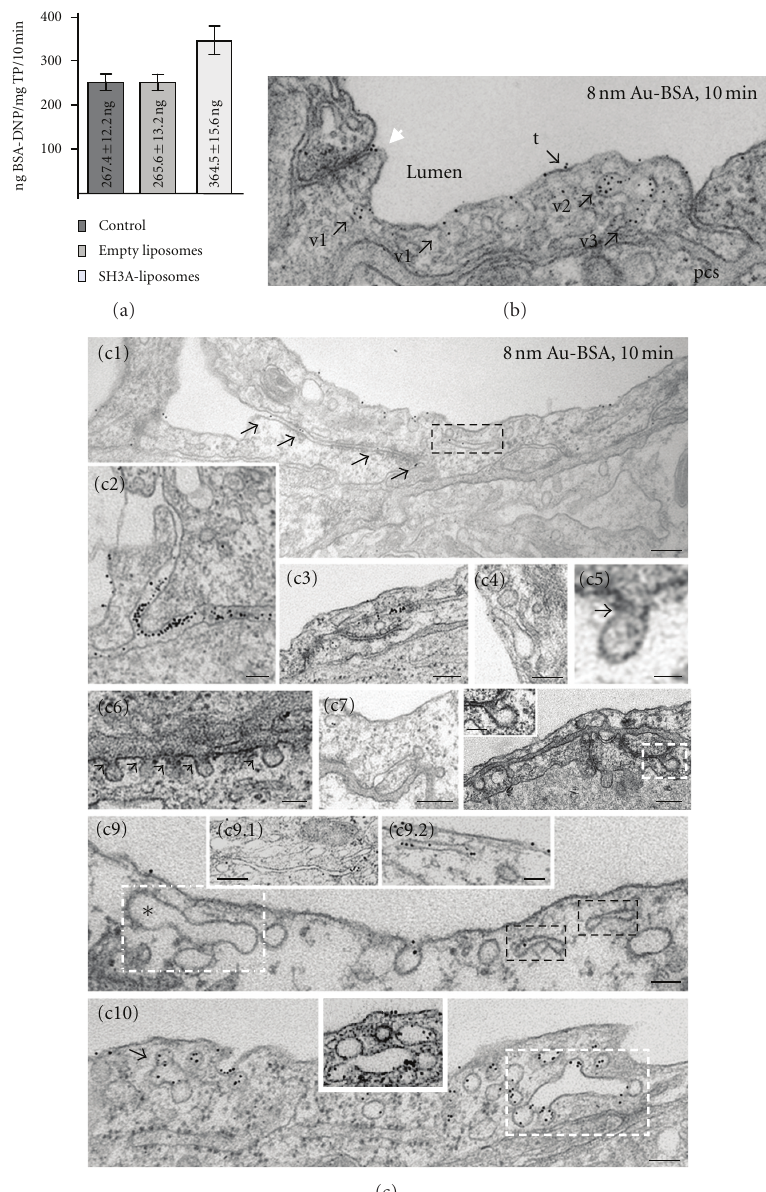
Figure 2: Increased endothelial permeability, impaired membrane fission, and increased occurrence of nonconventional endocytic/ transcytotic intermediates in the mouse lungs expressing the SH3A domain of ITSN-1s. (a) ELISA applied on mouse lung lysates of control, empty liposomes, and myc-SH3A-transduced mice perfused with 10 mg/mL BSA-DNP, for 10 min. Results were expressed in ng BSA-DNP/ mg total protein/10min. Bars ± SD. Results were obtained in 4-5 di ff erent experiments, with three mice per experimental condition. (b) Representative EM image showing the transendothelial transport of 8nm Au-BSA in control mouse lung. Tracer particles were detected in the vessel lumen, (t), in vesicles open to the luminal side of ECs (v1), in vesicles within the endothelial cytoplasm, (v2), and in vesicles discharging their load in the perivascular space (pvs; v3). Tracer particles did not permeate the IEJ and generated filtration residues (arrowhead), in the luminal introit of the junction. Scale bar: 100nm. (c) Representative electron micrographs showing transendothelial transport of 8 nm Au-BSA in SH3A-transduced mouse lung specimens as well as nonconventional endocytic/transcytotic intermediates in ECs expressing the SH3A domain of ITSN-1. Open IEJ permeated by 8 nm gold BSA complexes (c1) and heavy association of gold particles with the abluminal exit of an IEJ (c2). Caveolae (c3, c4, arrows) and clathrin-coated pits (c7, arrow) with very long necks, and caveolae with their narrow necks surrounded by staining-dense collars (c5, c6 arrowheads) were frequently observed. A clathrin-coated pit with elongated neck is shown (c8, boxed area, inset). Elongated elements and tubular membranous structures, labeled by gold particles (c1, c9, black boxed structures, c9.1, a9.2) and comprising caveolae and coated pits (c9, c10, white boxed structures) as well as large and uncharacteristic caveolae clusters (c10, arrow and inset). Bars: 200 nm—(c1), (c3), (c7), (c8), (c9.1); 100nm—(c2), (c4), (c6), (c9), (c8) inset, (c10); 50nm—(c5),